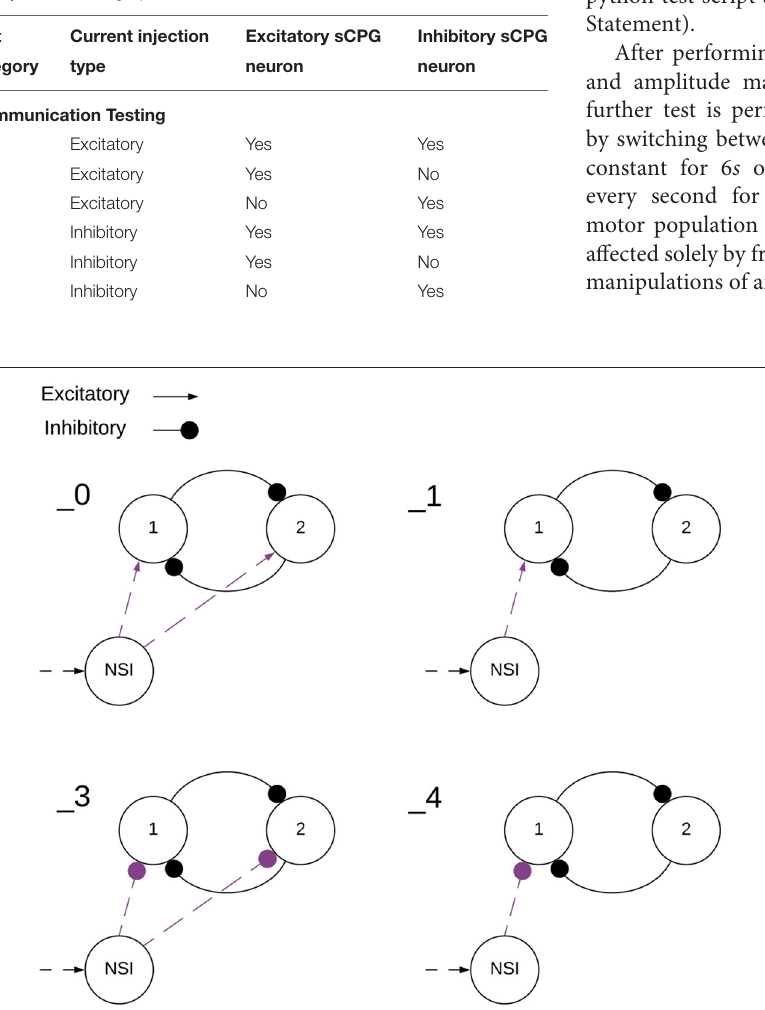
Frontiers in Neuroscience |